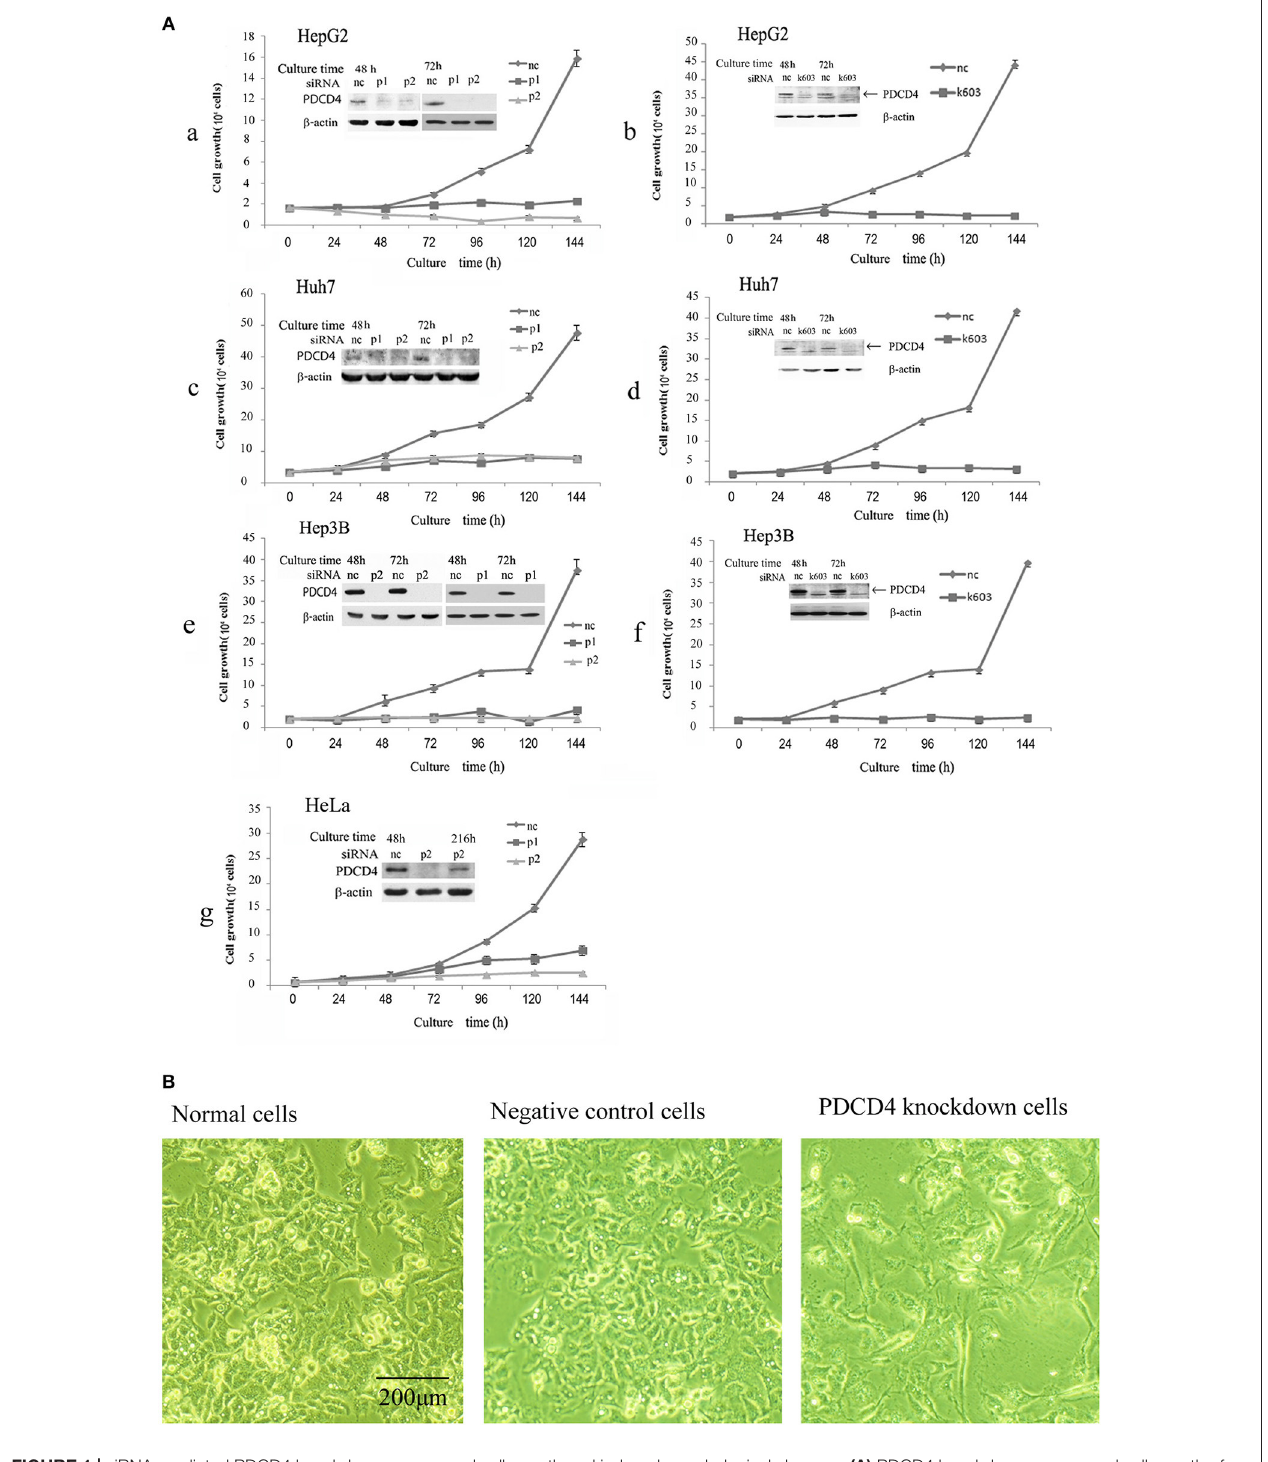
FIGURE 1 | siRNA-mediated PDCD4 knockdown suppressed cell growth and induced morphological changes. (A) PDCD4 knockdown suppressed cell growth of HepG2 (a,b) , Huh7 (c,d) , Hep3B (e,f) , and HeLa (g) cells. Cells were transfected with three types of PDCD4-specific siRNAs: p1 or p2 (a,c,e,g) and k603 (b,d,f) , and a negative control siRNA (nc). Cell growth was analyzed by counting the cell numbers under a microscope at different time points, as indicated in the figures. (B) Phase-contrast images of the normal (left), negative control siRNA-treated (middle) and p2 siRNA-mediated PDCD4 knockdown HepG2 cells (right) at 48h after siRNA